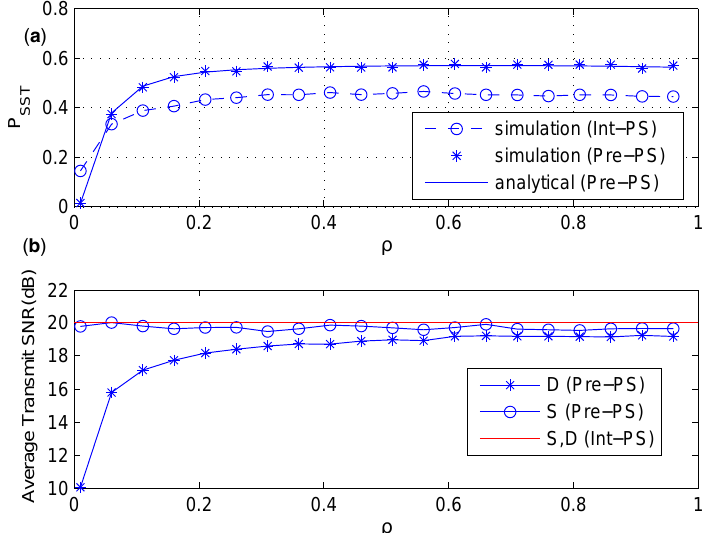
Figure 5. ( a ) P SST under various ρ . ( b ) The average transmit SNR under various ρ .